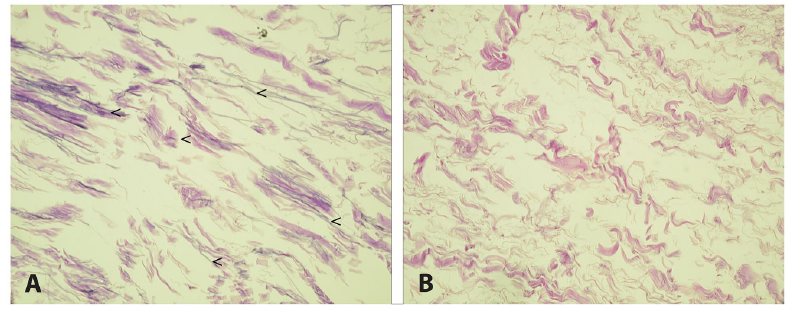
Fig 4. Coracohumeral ligament (CHL). CHL retrieved from shoulders with EIPMT (A) showed a higher number of specimens with large amounts of elastic fibers (arrowhead) compared to normal shoulders (B). (resorcin-fuchsin stain, original magnification x20).